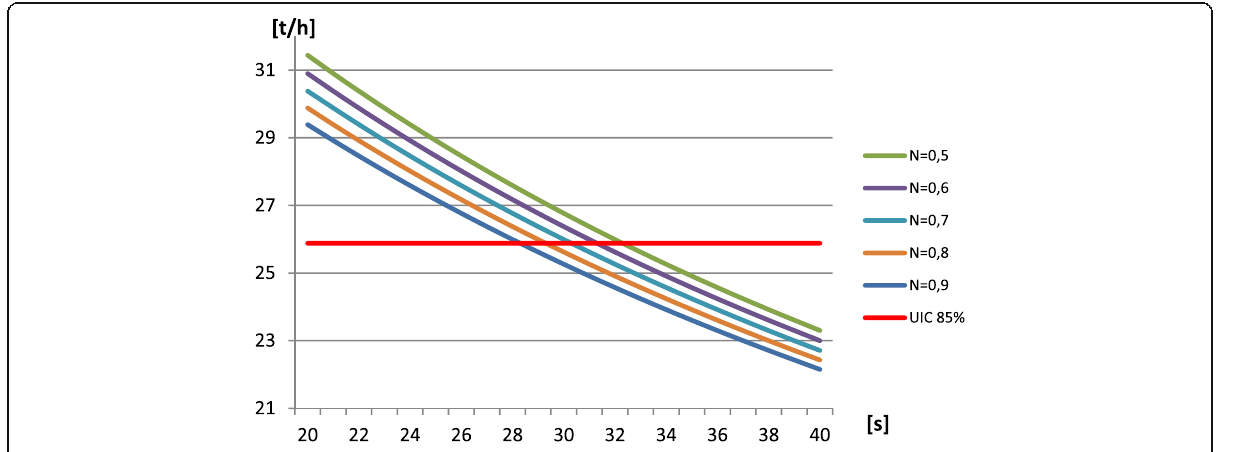
Fig. 15 Operative Capacity VS T Dk for different values of Necessity. T DL =